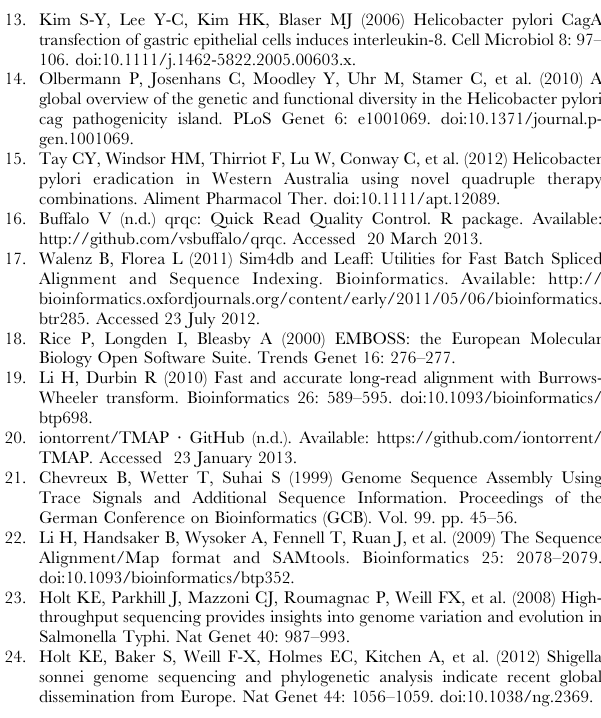
Figure S2 QRQC analysis of J99 raw sequence data derived by Illumina Nextera. Plots of the quality distribution by base position for read 1 (a) and read 2 (b). Proportions of each base with respect to the position in read 1 (c) and read 2 (d). Histograms of the read 1 lengths (e) and read 2 lengths (f). Mean GC proportion for each position in read 1 (g) and read 2 (h). Figure S3 QRQC analysis of J99 raw sequence data derived by Illumina Nextera XT. Plots of the quality distribution by base position for read 1 (a) and read 2 (b). Proportions of each base with respect to the position in read 1 (c) and read 2 (d). Histograms of the read 1 lengths (e) and read 2 lengths (f). Mean GC proportion for each position in read 1 (g) and read 2 (h).